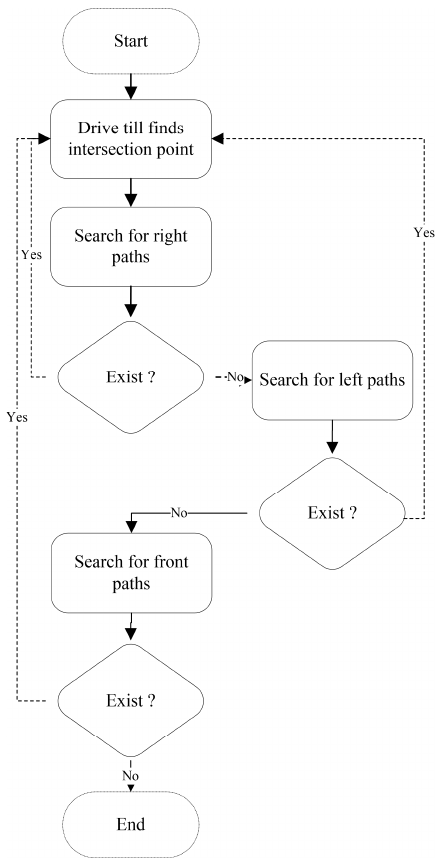
Figure 4. The flowchart for the MWFS approach.